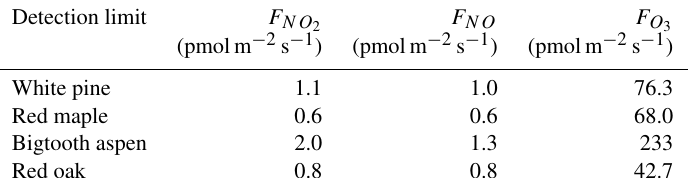
Table 1. Detection limits of the foliar fluxes of NO 2 , NO, and O 3 . These were determined using the flux data obtained during the nighttime scrubbed air purges when no foliar gas exchange was expected. These limits mainly reflect the measurement precision of the trace gas concentrations at the inlets and outlets of the branch and reference enclosures, variations of the enclosure conditions over time, and the fluctuation of the purge air flow rate.